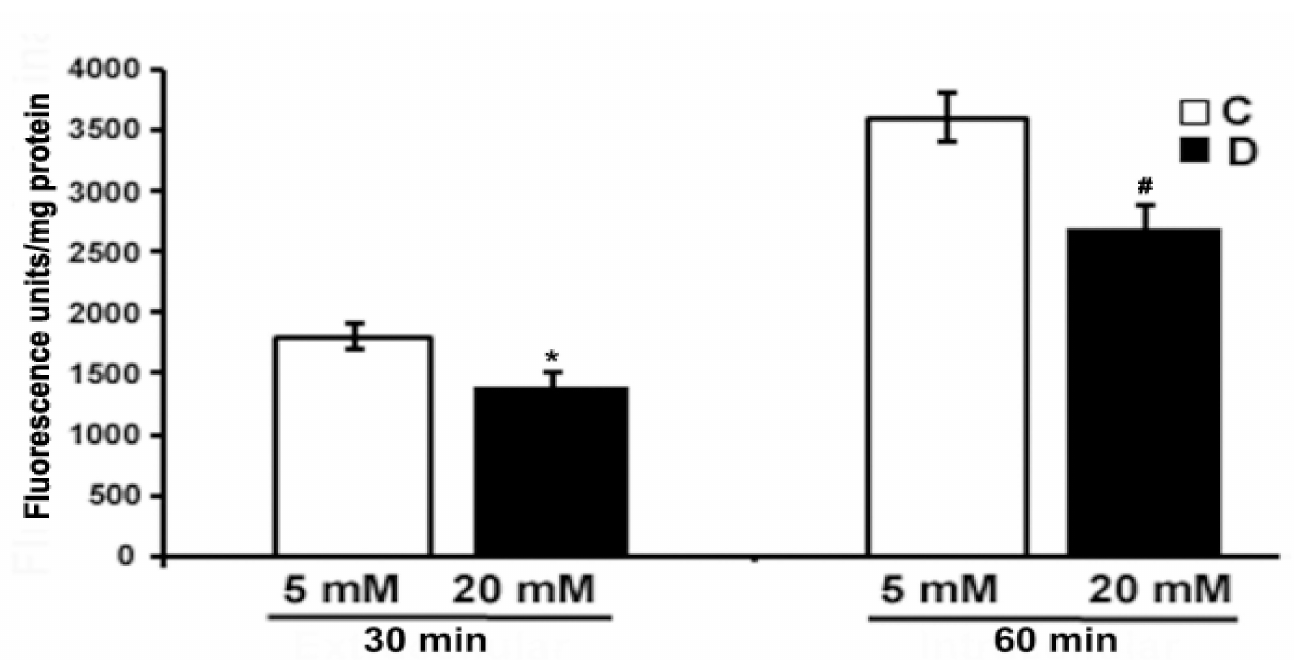
Figure 5. Measurement of oxidative stress in excised control and diabetic retina using fluorescent ROS indicator. Excised retinas from 10 weeks control and diabetic retinas were incubated in the Krebs bicarbonate buffer with 10 µ M CM-H 2 DCFDA for 30 and 60 min. The fluorescence intensity of oxidized H 2 DCFDA was measured within the retina as described in the method section. Fluorescence from oxidized H 2 DCFDA in the retina is proportional to ROS. Data are expressed as means ± SEM (n = 5–6 for each). * ,# p < 0.05, diabetic versus control